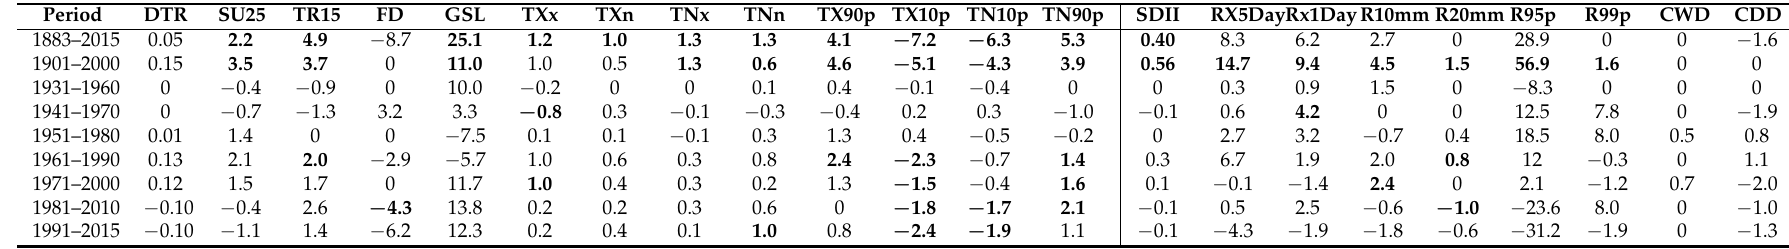
Table 6. As for Table 5 but for ETCCDI climate indices (Table 1). ( ◦ C, Days, % or mm per century for 1883–2015 and 1901–2000, per decade for other periods). Trends for CSDI and WSDI have been excluded here as they are neutral for all time periods. Bold values indicate trend significance ( p <